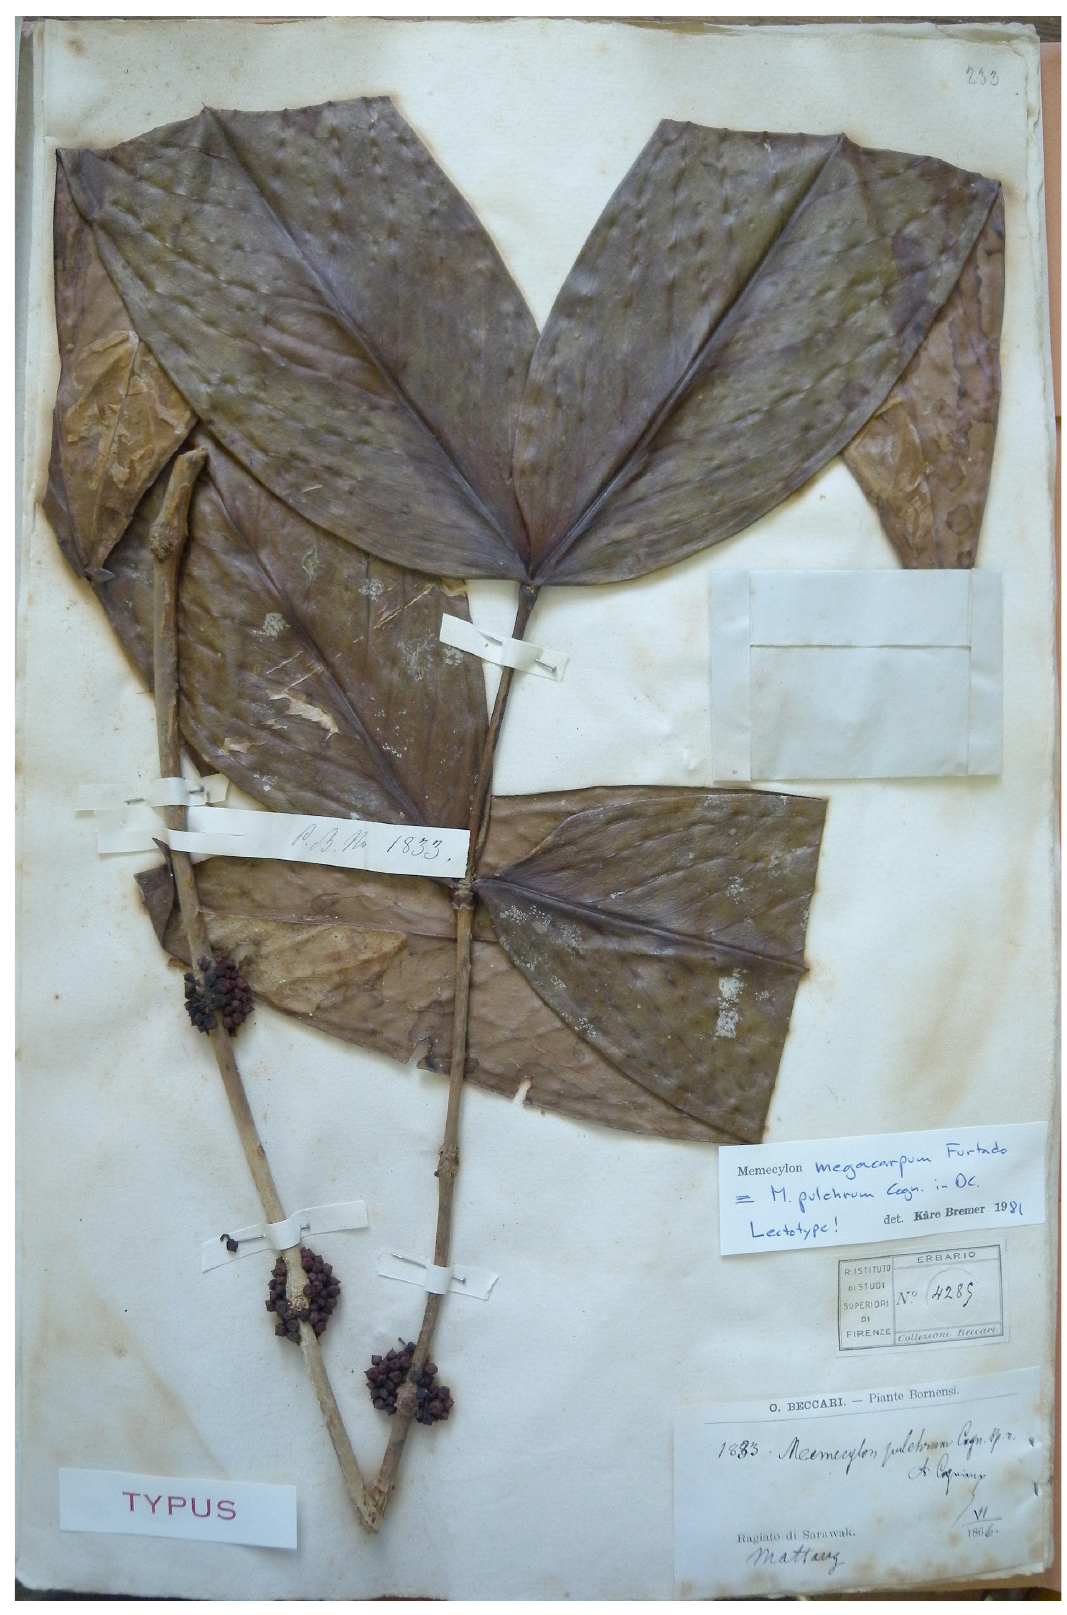
Fig. 1. Image of a syntype of Memecylon megacarpum Furtado [ Beccari 1833